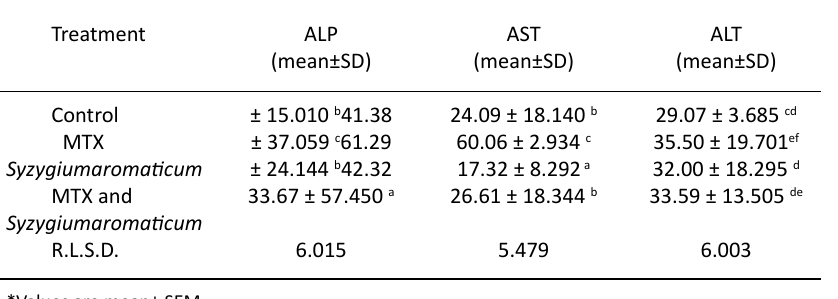
*Values are mean±